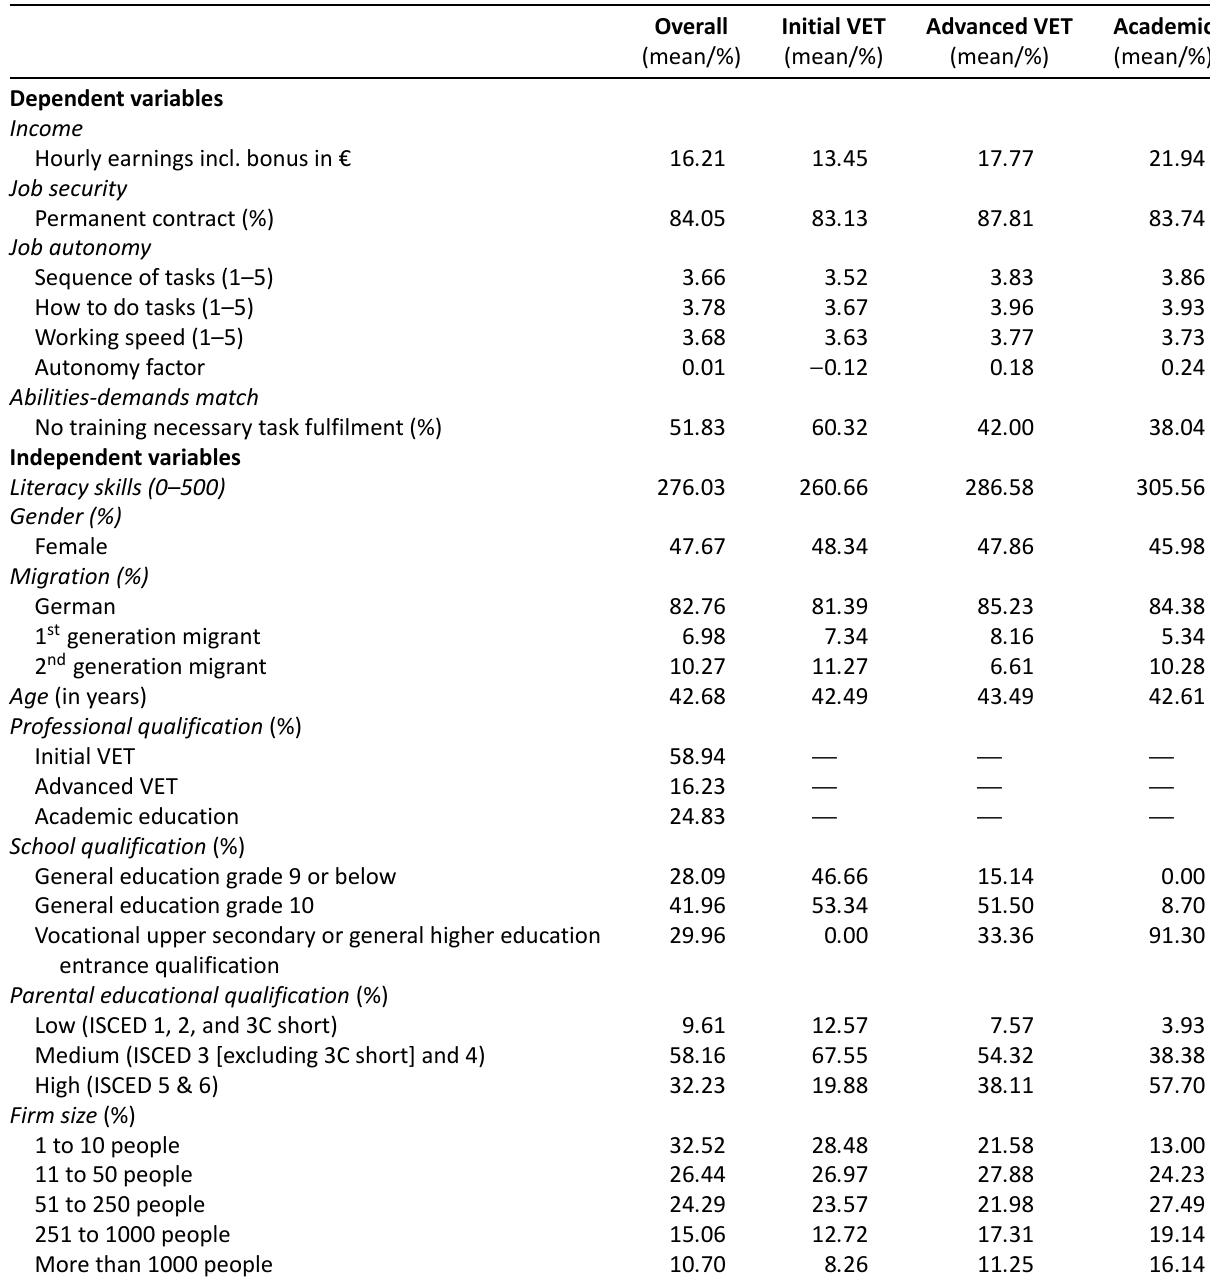
Table 1. Summary